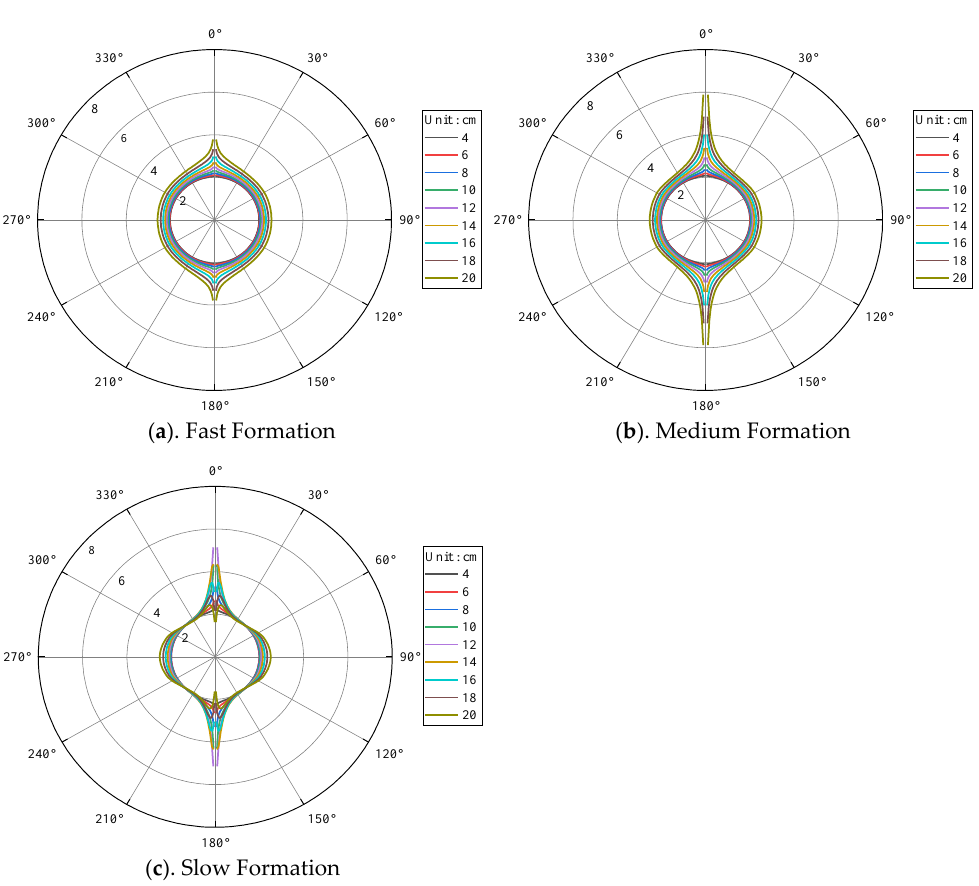
Figure 9. Radiation characteristics of SH–wave of a dipole source under different borehole radii with the main frequency of the dipole source 1 kHz.